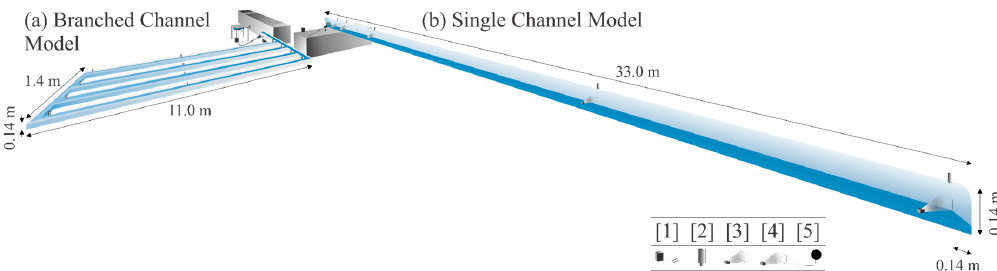
Figure 2. Drawing of the branched channel model ( a ) and the single channel model ( b ).